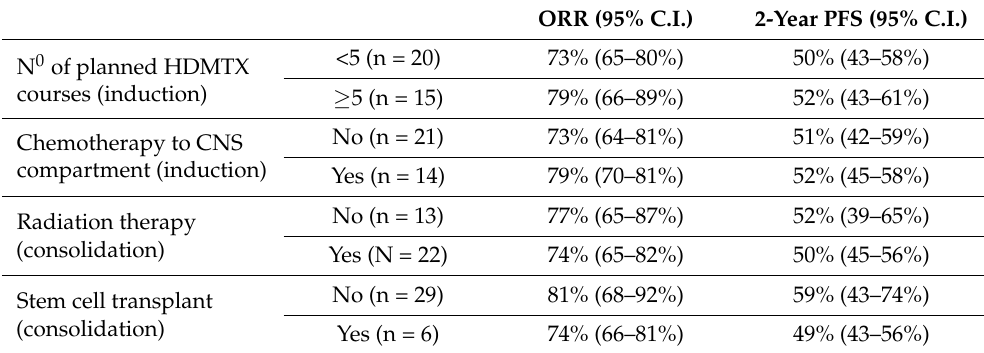
Table 2. Pooled estimates for ORR and PFS among the cohorts categorized by number of planned courses, CNS chemotherapy, radiation therapy, and stem cell